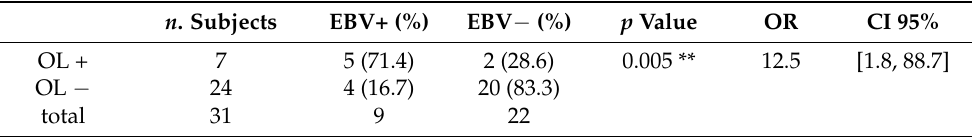
Table 2. Epstein–Barr virus (EBV) detection by qPCR in salivary swabs from subjects with oral lesions (OL+) and without oral lesions (OL −